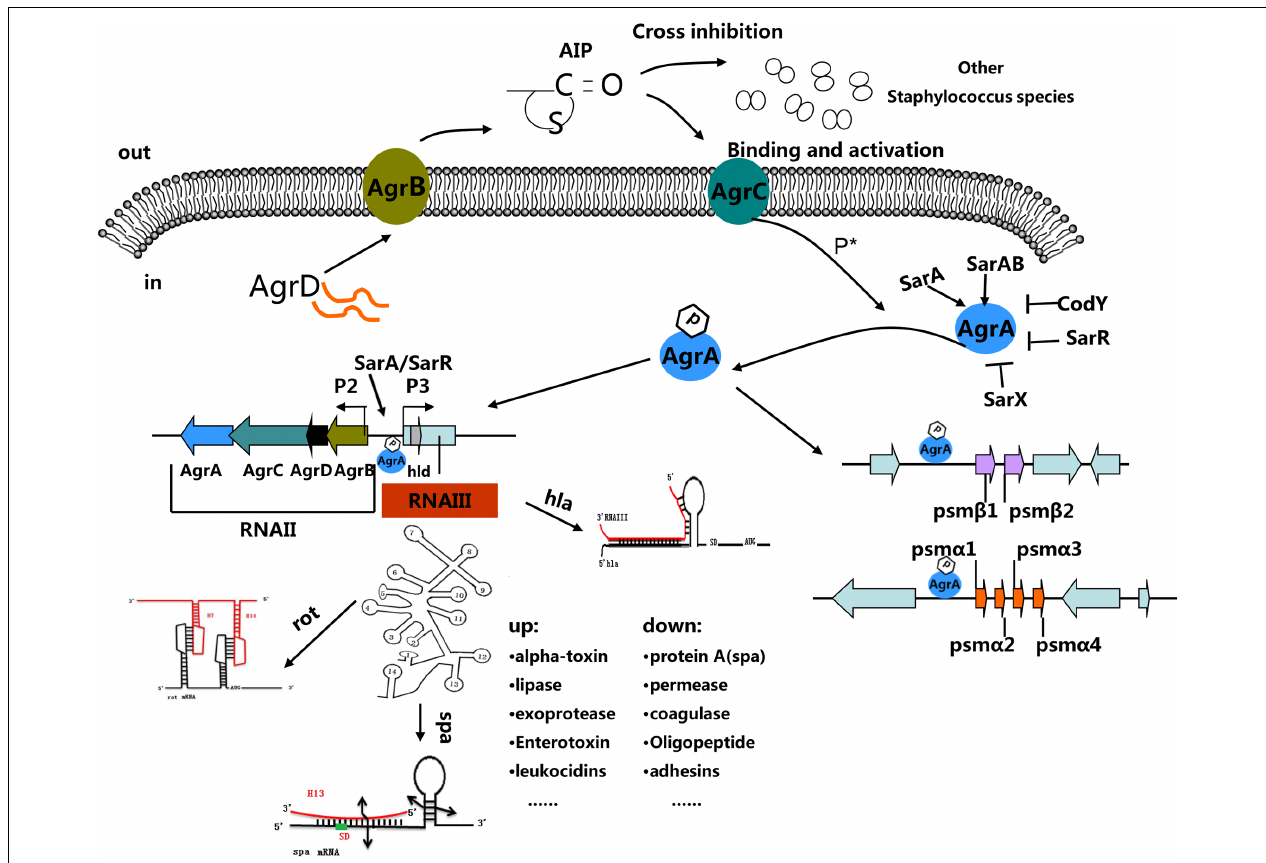
FIGURE 1 | The Staphylococcal quorum-sensing system. The agr locus is composed of divergent transcripts designated RNAII and RNAIII, driven by promoters P2 and P3, respectively. The AIP signal is produced from the AgrD precursor, while the membrane-localized enzyme AgrB participates in the maturation and export of the AIP. At a critical threshold concentration, AIP activates the two-component signal transduction system, AgrC–AgrA, and causes the phosphorylation of AgrA. Once phosphorylated, AgrA binds to the P2 and P3 promoter regions, as well as promoters PSM- α and PSM- β , resulting in agr system transcription. RNAIII encodes the delta-toxin encoding gene hld, and 14 stem-loop motifs. These domains regulate the expression of numerous virulence factors. Other regulators (such as SarA, SrrAB, SarR and SarX) can enhance or inhibit agr